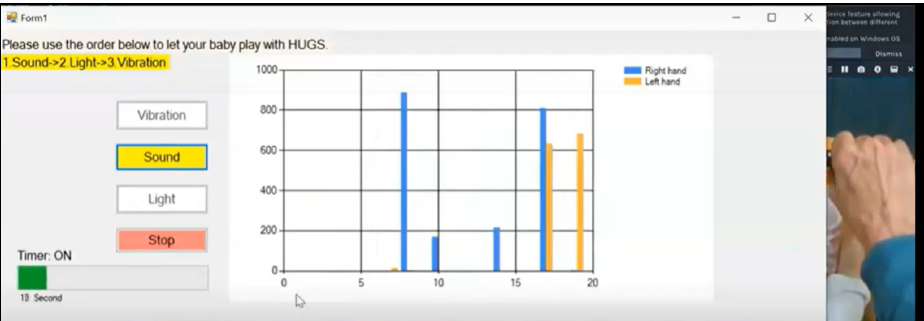
Figure 10. HUGS ‐ 2 GUI (graphical user interface). Figure 10. HUGS-2 GUI (graphical user